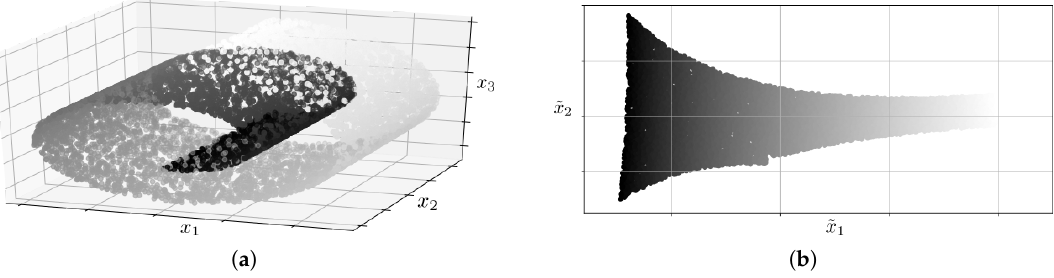
Figure 4. Example of feature extraction using LLE, a technique based on manifold learning, from [17]. ( a ) samples ¯ x in the N -dimensional original space; ( b ) samples ˜ x in the q -dimensional transformed